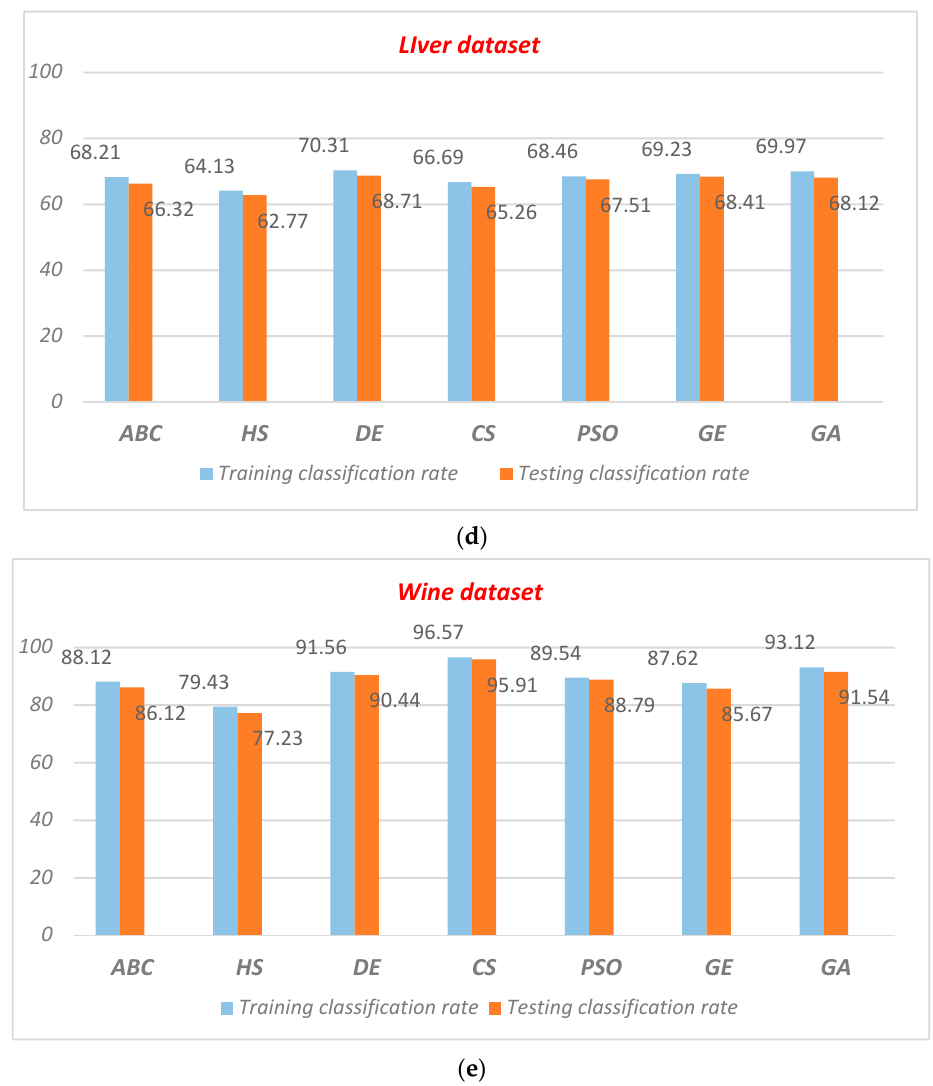
Figure 7. Classification rate of the training and testing results for seven datasets, including ( a ) Iris, ( b ) Cancer, ( c ) Diabetes, ( d ) Liver, and ( e ) Wine.